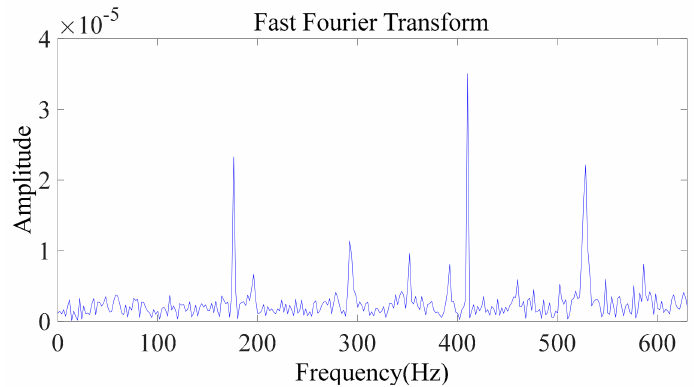
Figure 4. Fast fourier transform (FFT) spectrum of the vibration signal (using a rotation speed of 3000 rpm as an example).